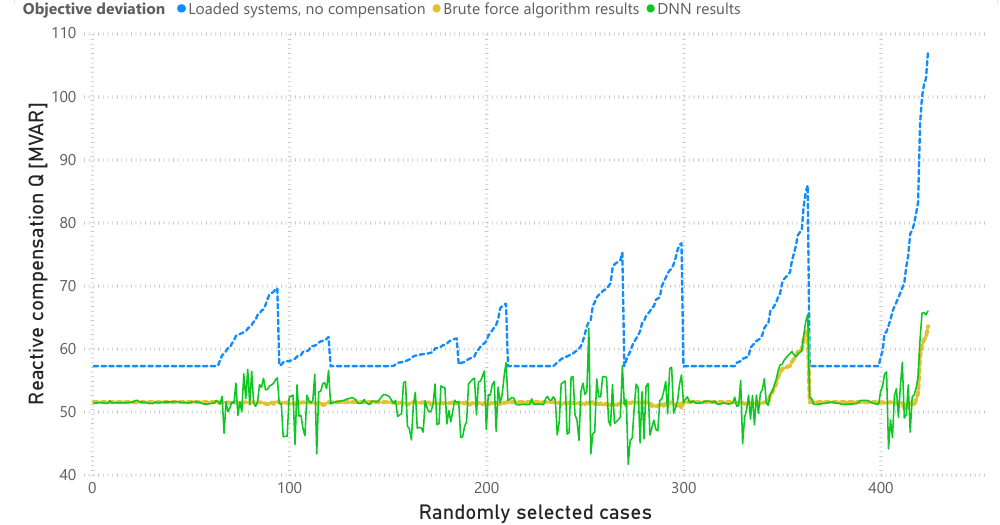
Figure 4. Objective deviations for 424 scenarios: original system, loaded system, brute force results and DNN results.